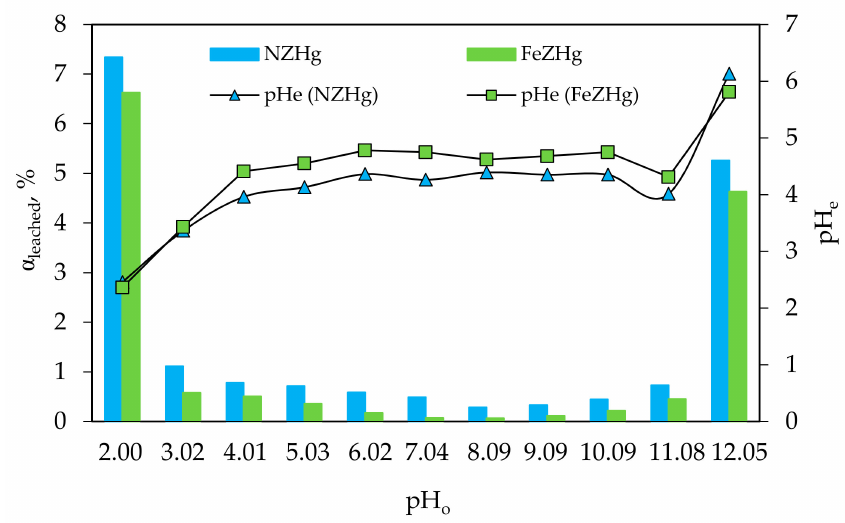
Figure 12. Amount of leached Hg(II) from saturated NZHg and FeZHg as a function of pH o as well as pH e as a function of pH o